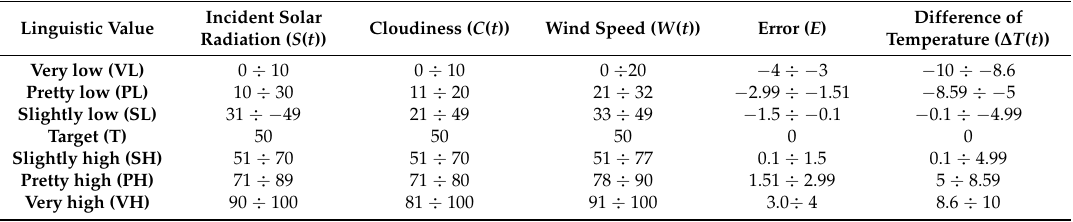
Table 1. Linguistic values of the